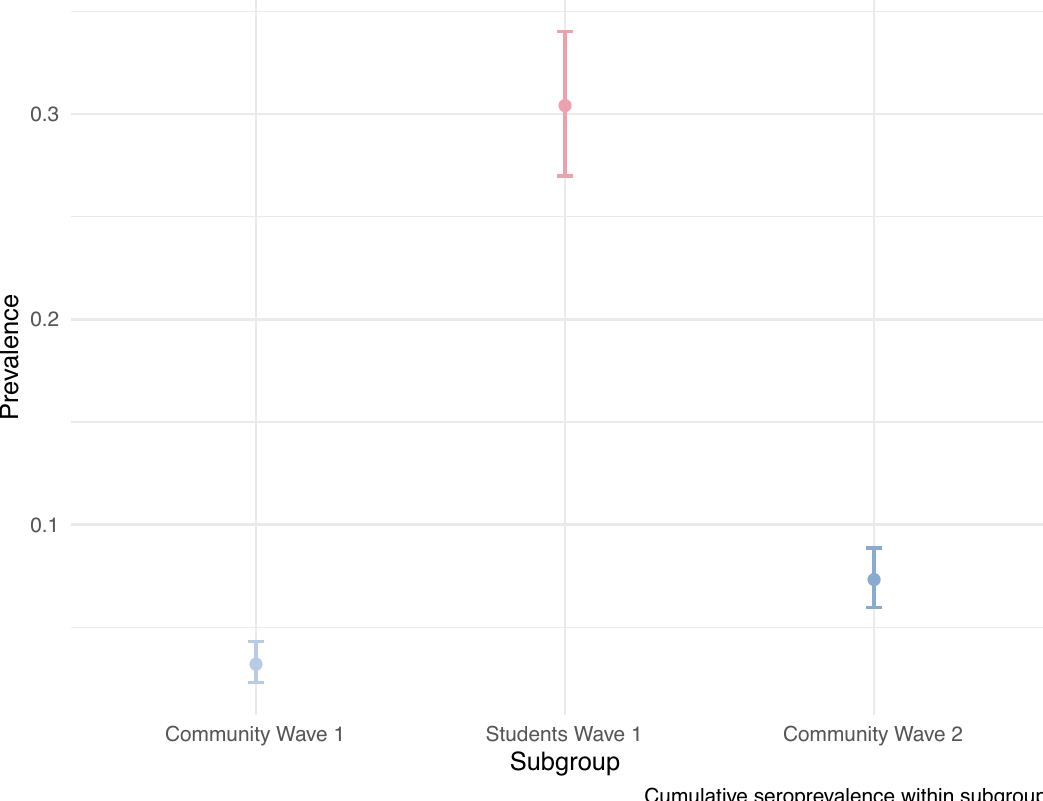
Figure 2. Raw seroprevalence (circles) with 95% binomial confidence intervals for the community residents at the first visit at the start of the Fall 2020 term (light blue), returning students at the end of the fall 2020 term (red), and community residents at either the first or the second visit after student departure (dark